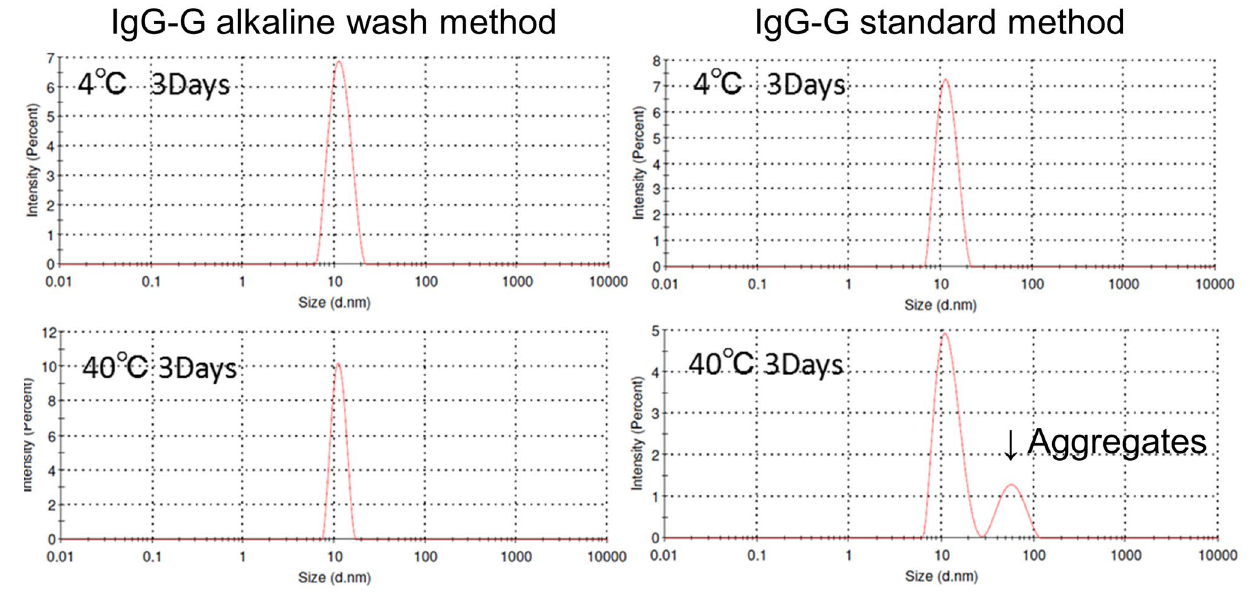
Figure 5. DLS profiles of short-term stability test samples of